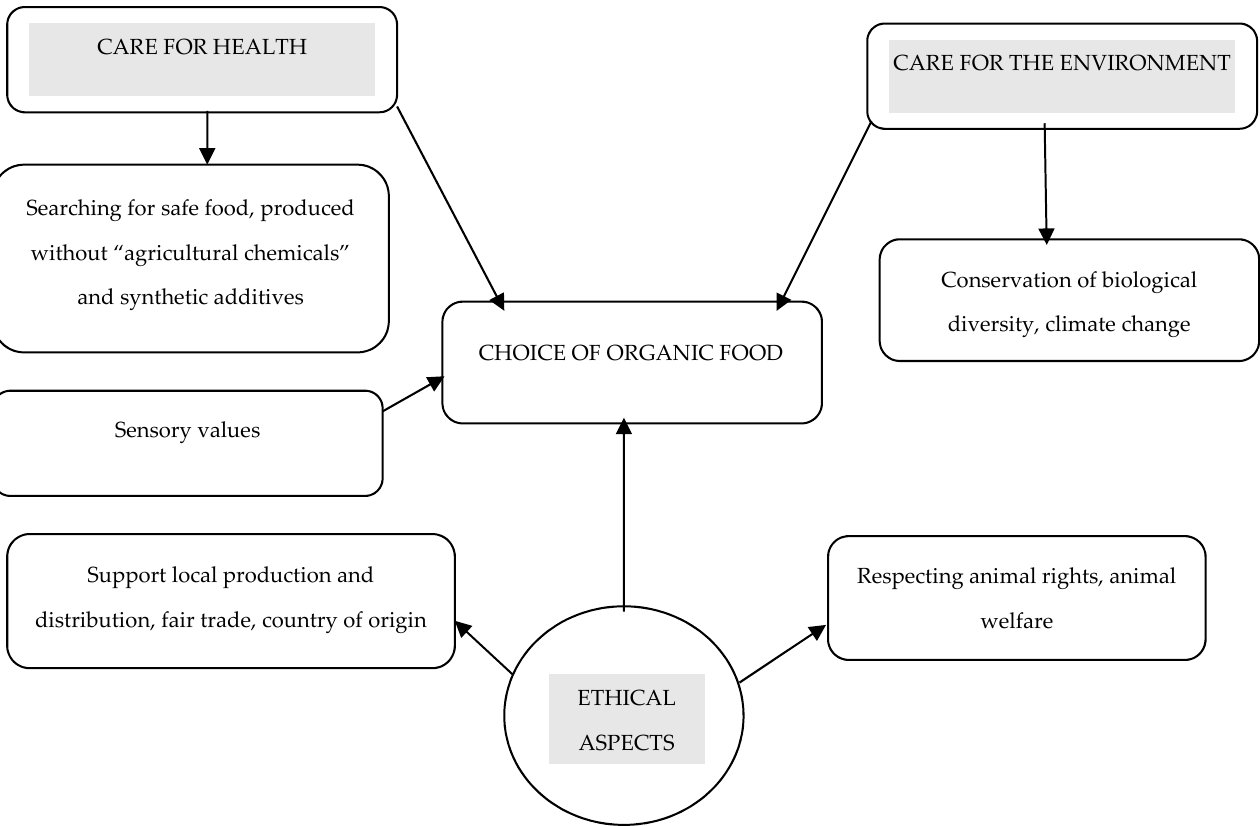
Figure 1. Factors determining the choice of organic food. Source: Raport Ministerstwa Rolnictwa i Rozwoju Wsi [27].